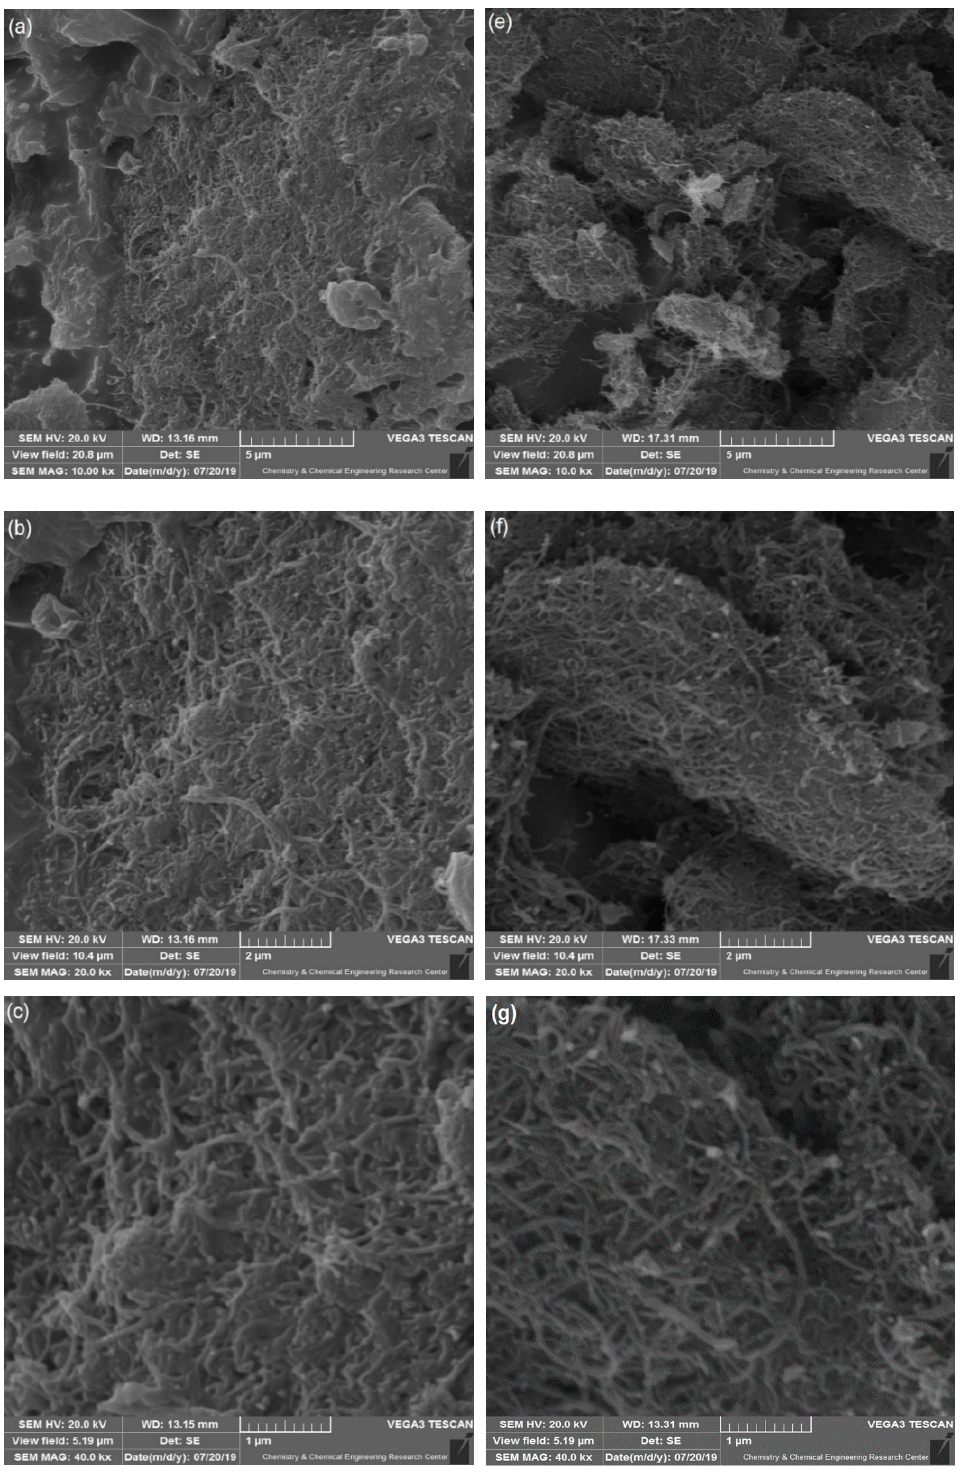
Figure 9. Scanning electron microscopy (SEM) micrographs of ( a – c ) SAN-g-PCNTs and ( e – g ) Figure 9. Scanningelectronmicroscopy(SEM)micrographsof( a – c )SAN-g-PCNTsand( e – g SAN-g-FCNTs.